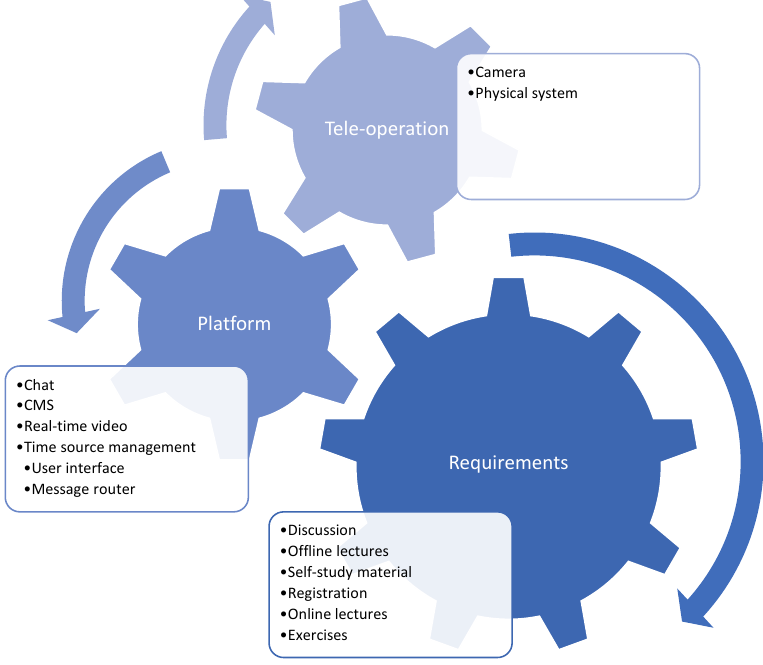
Figure 1. Figure describing user requirements and services providing required functionalities. Figure also describes connections between platform